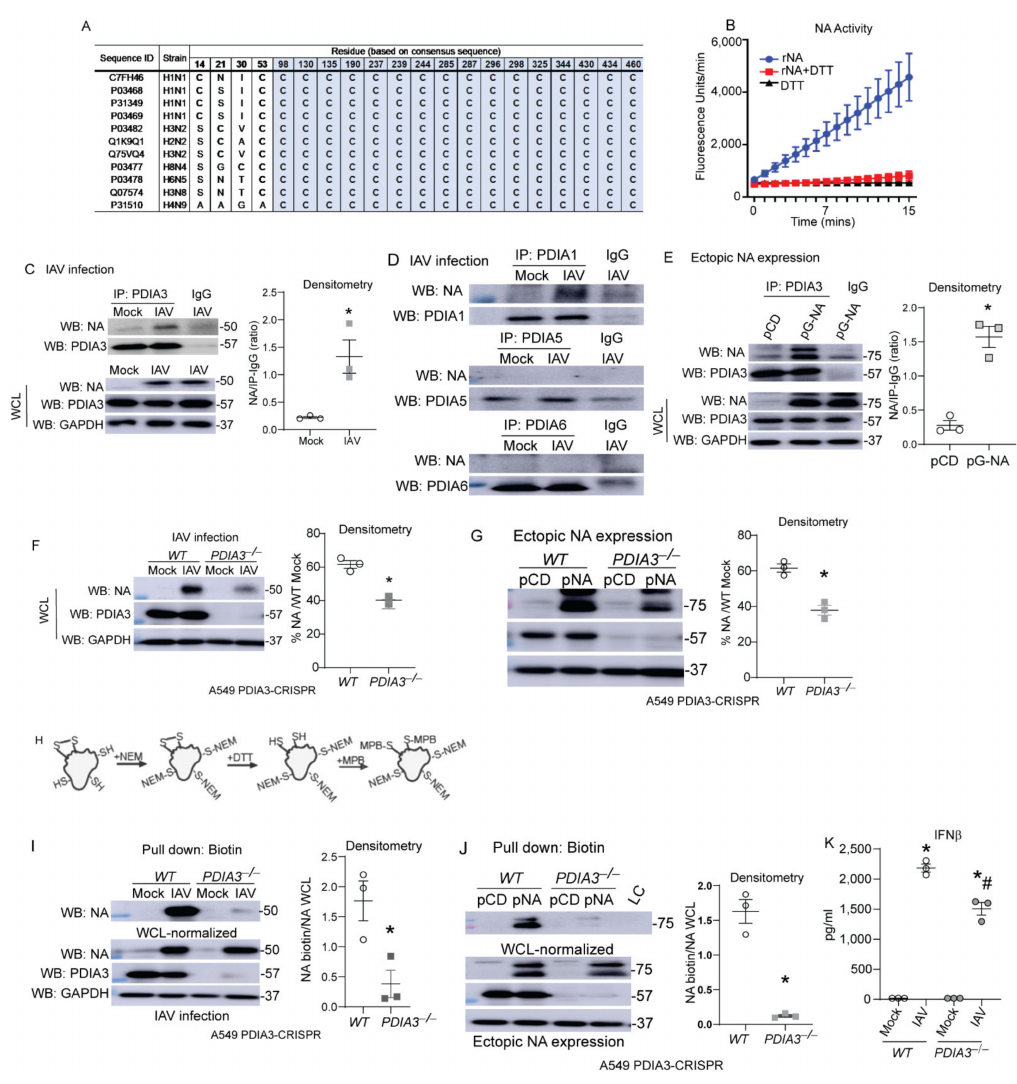
Figure 1. PDIA3 interaction with influenza NA required for disulfides of NA. ( A ) Multiple align- ments of conserved cysteine residues that are involved in disulfide bonds (grey) of NA. ( B ) Re- combinant NA (rNA-5 µ g) activity assay ( ± reducing agent-DTT-1 mM). ( C , D ) NA interaction with PDIA3/PDIA1/A5/A6 assessed by respective PDIA immunoprecipitation in mock or influenza- infected cells. ( E ) pCDNA3 or pNA-transfected A549 cells, NA interaction assessed by PDIA3 immunoprecipitation. ( F , G ) Expression of NA in PDIA3 ablated ( PDIA3 − / − ) or WT A549 cells infected (left) or transfected with plasmids (right) with densitometry. ( H ) Schematic depicting disul- fide labeling assay. ( I , J ) Western blots for NA labeling of disulfides in samples normalized with higher total protein in PDIA3 − / − A549 cells infected (left) or transfected with plasmids (right) with densitometry of disulfide labeled proteins. ( K ) IFN β measurement by ELISA. * p < 0.05 compared to mock or WT groups by t -test. # p < 0.05 compared WT + IAV group. Data are expressed as the standard error of the mean ( ±